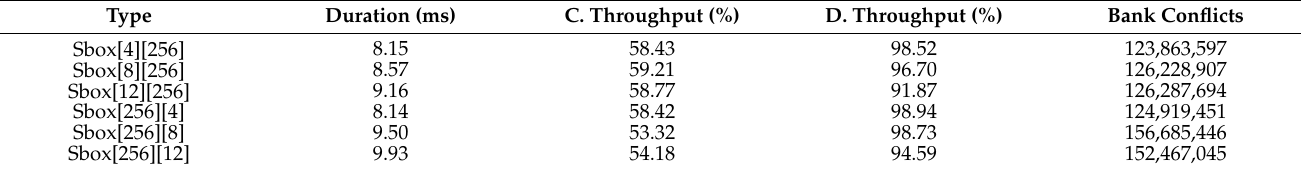
Table 4. Performance by number of Sbox table copies (C.: compute, M.: memory, block: 1024 × 32, thread: 256).